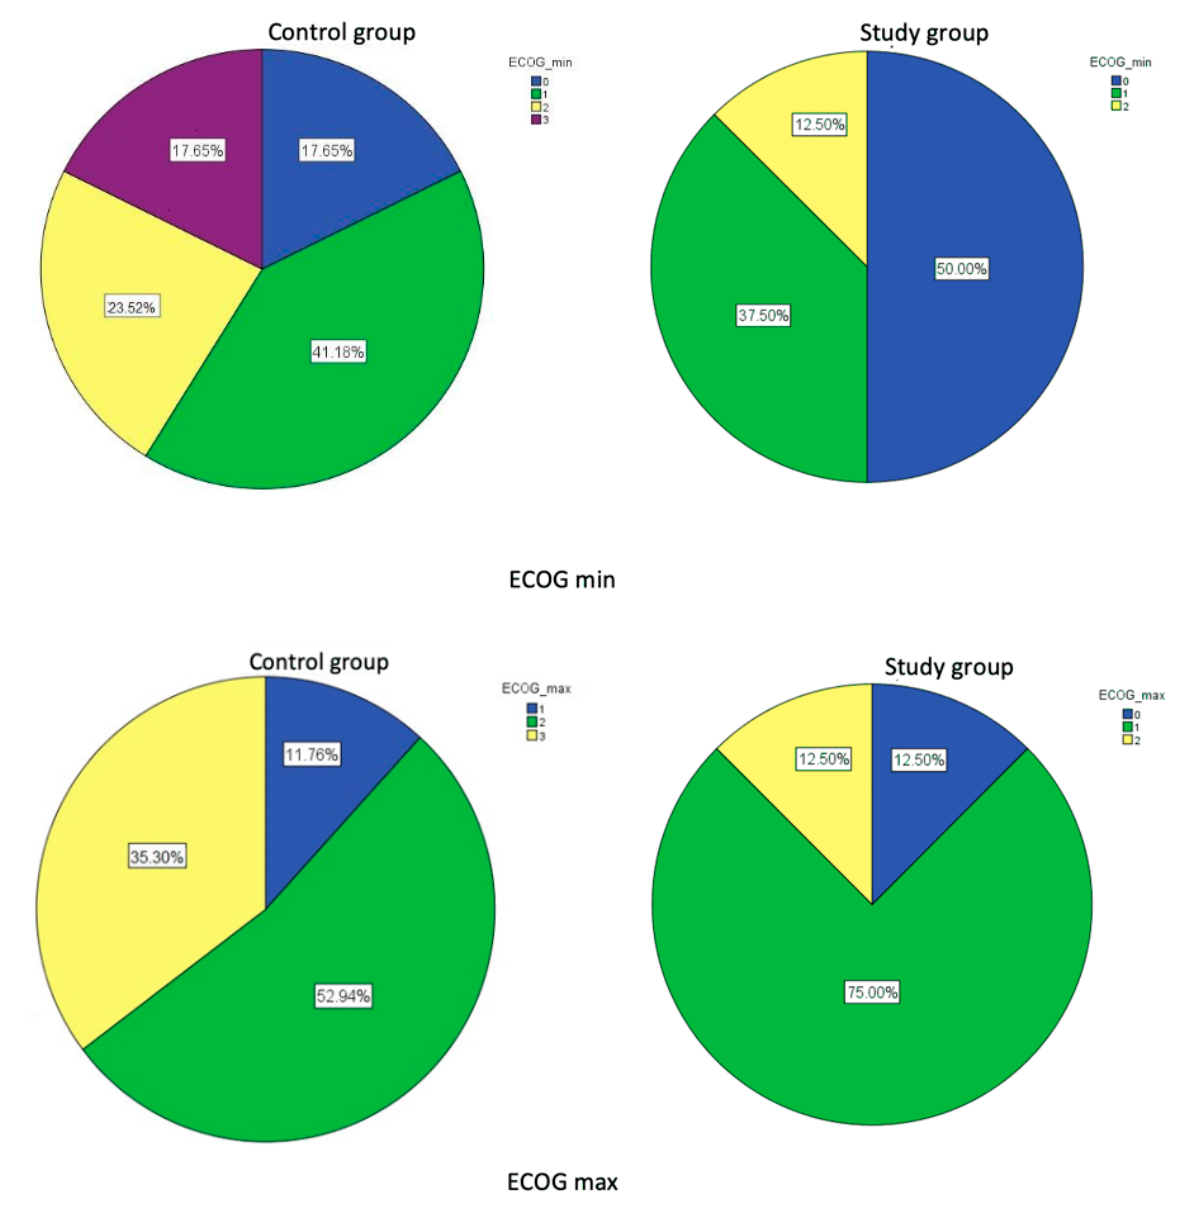
Figure 2. Minimal and maximal EGOC score distributions within the study and control groups. Table 1. Survival rates from study